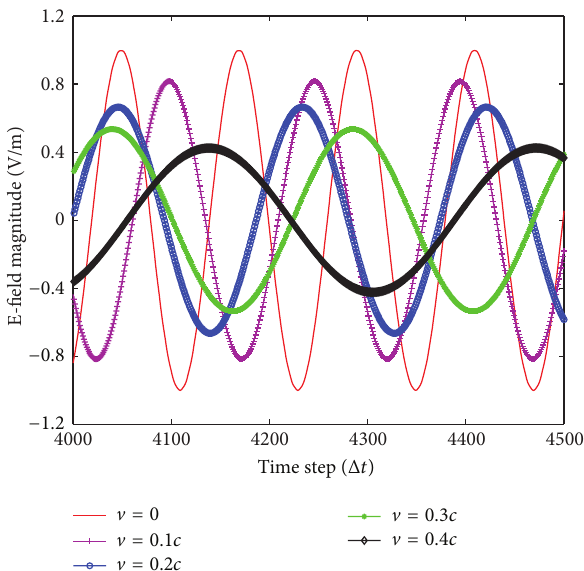
Figure 5: Frequencies of the scattered waves from the conducting surface moving along the + 𝑧